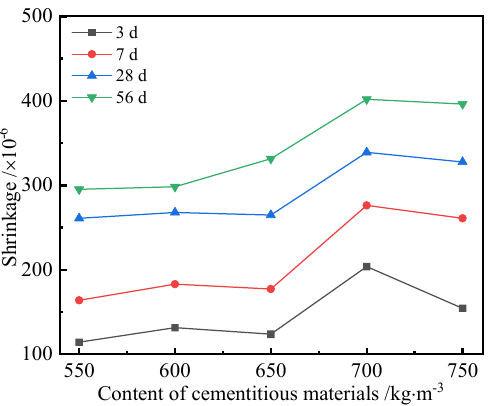
Figure 6. Shrinkage curves of the UHPC with different contents of cementitious materials.